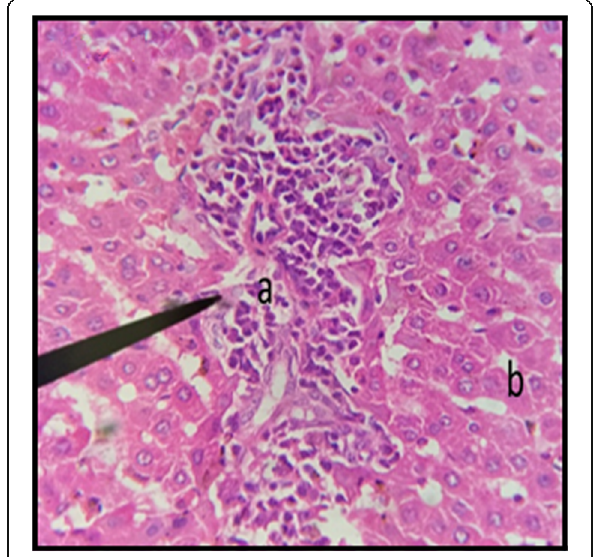
Fig. 13 Liver Section of Male Rat (50 mg/kg/day) X400. a inflammation in portal vein, b normal sinusoids